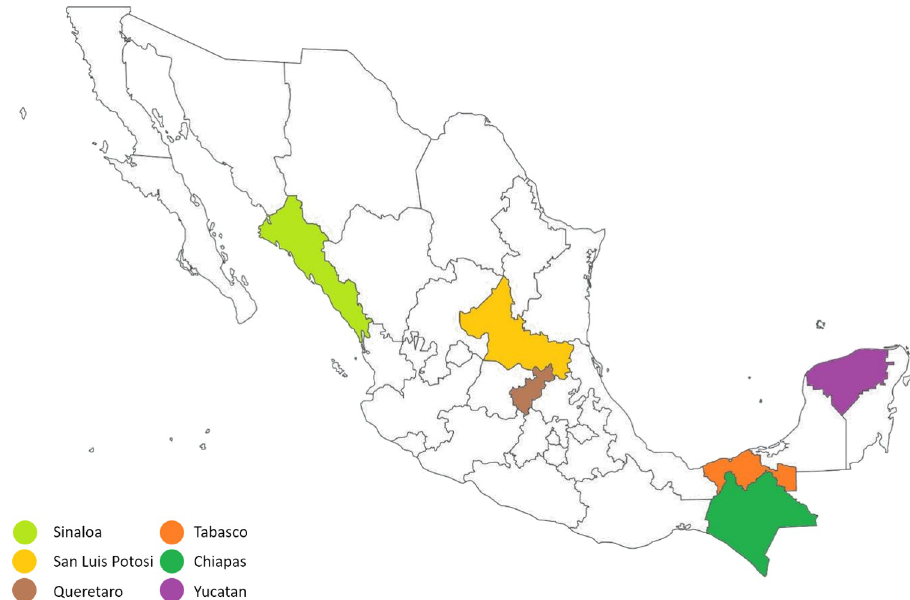
Fig 1. Sample collection. The samples were obtained in the states of Yucatan (purple), Tabasco (orange), Chiapas (green), Queretaro (brown), San Luis Potosi (yellow) and Sinaloa (light